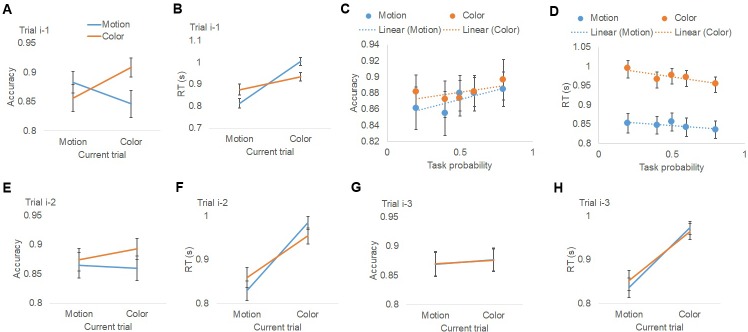
Behavioral results.(A, B) Group mean (±MSE) of accuracy (A) and RT (B), plotted as a function of task on the previous trial (i-1) and current trial. Results for trials i-2 and i-3 are plotted similarly in (E, F) and (G, H), respectively. (C, D) Group mean (±MSE) of accuracy (C) and RT (D), plotted as a function of (i) the pre-cue’s prediction of encountering the actual task and (ii) the task on the current trial.